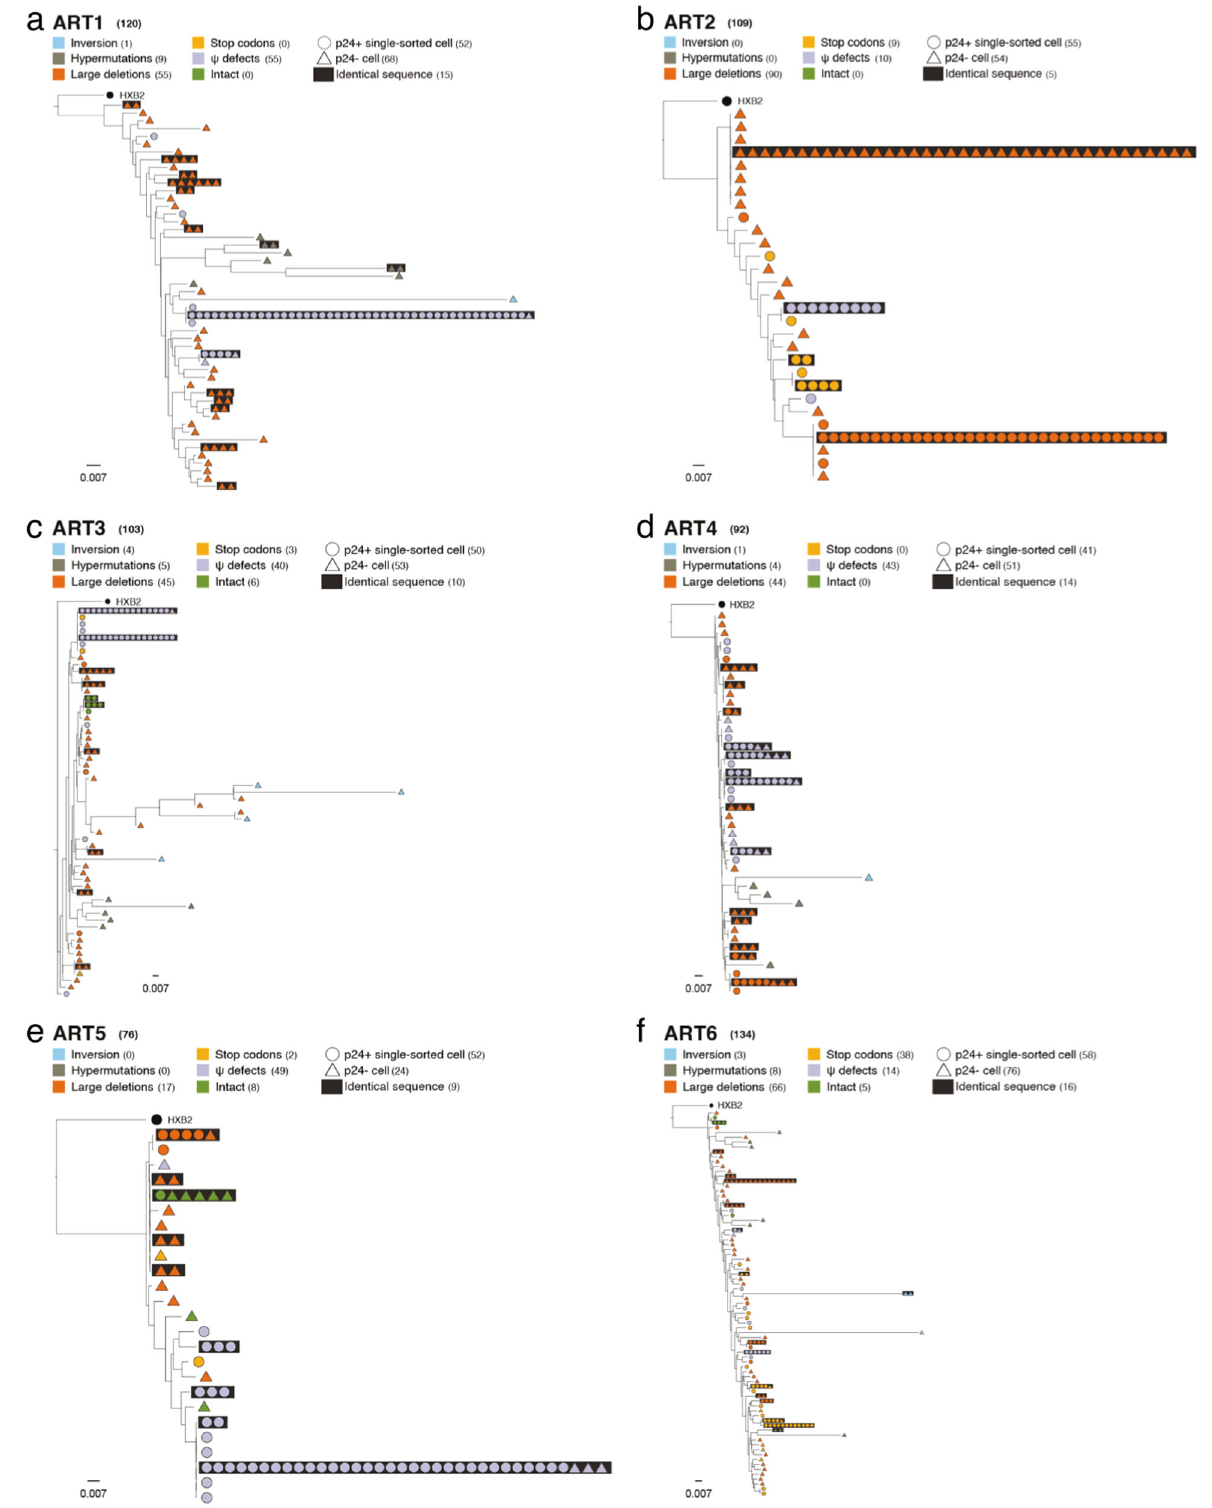
Fig. 2 | Phylogenetic analysis of HIV genomes in p24+ and p24 − populations from 6 ART-treated participants. Maximum-likelihood phylogenetic trees of proviralgenomesretrievedfromp24+cells(dot)andp24 − cells(triangle)fromthe 6 participants: a ART1, b ART2, c ART3, d ART4, e ART5 and f ART6. Each genetic